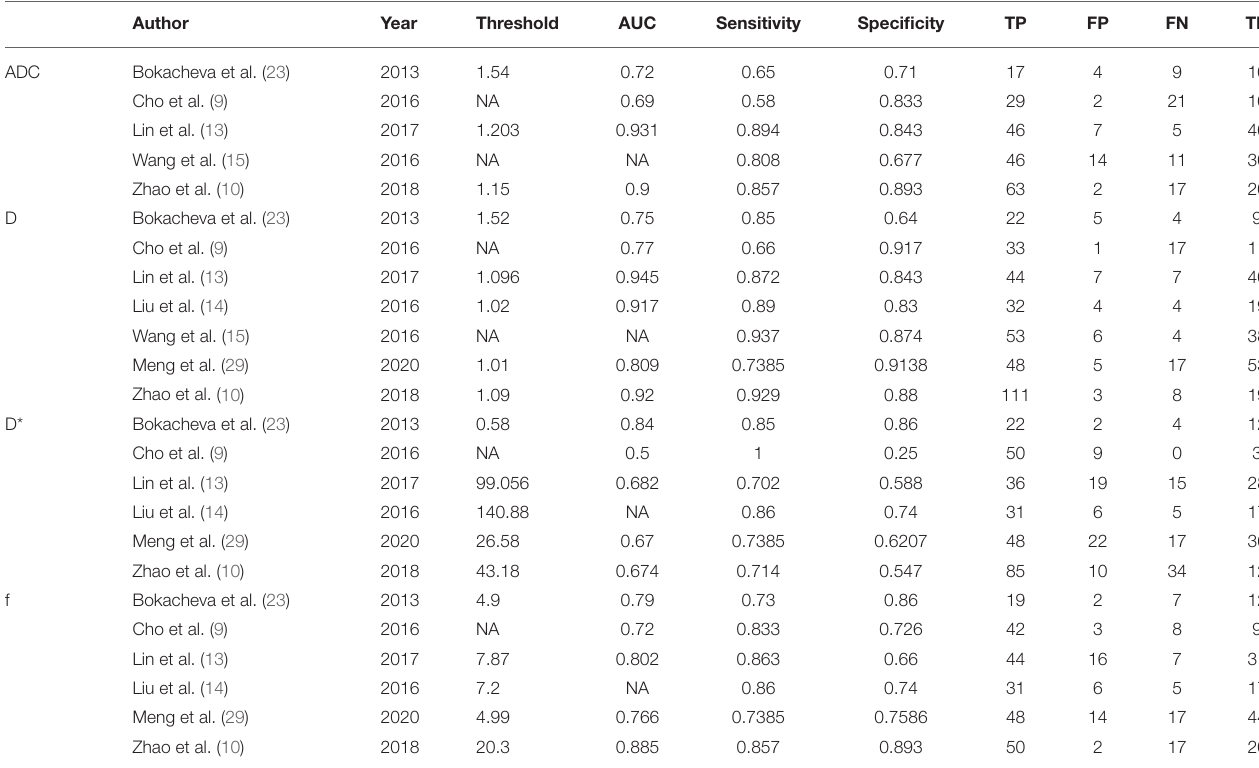
TABLE 2 | Diagnostic performance of each included